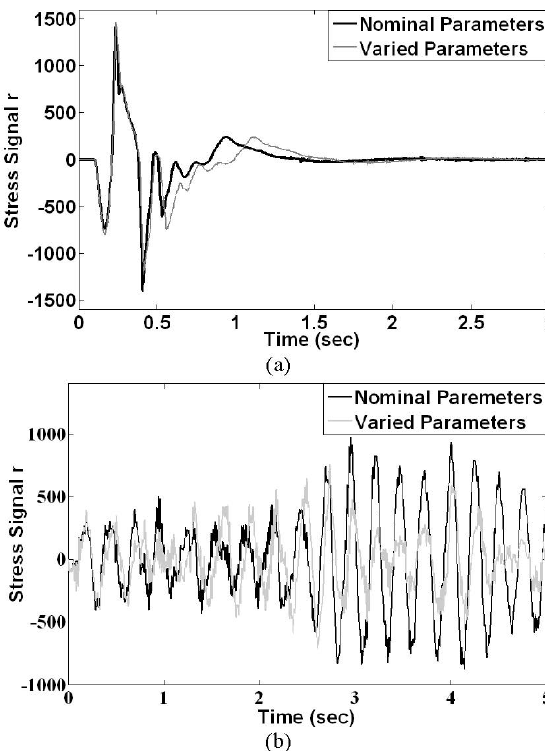
Figure 13. Critic signals for the system with nominal and varied parameters while is imposed by (a) bump road profile depicted in Figure 3, (b) random road profile depicted in Figure